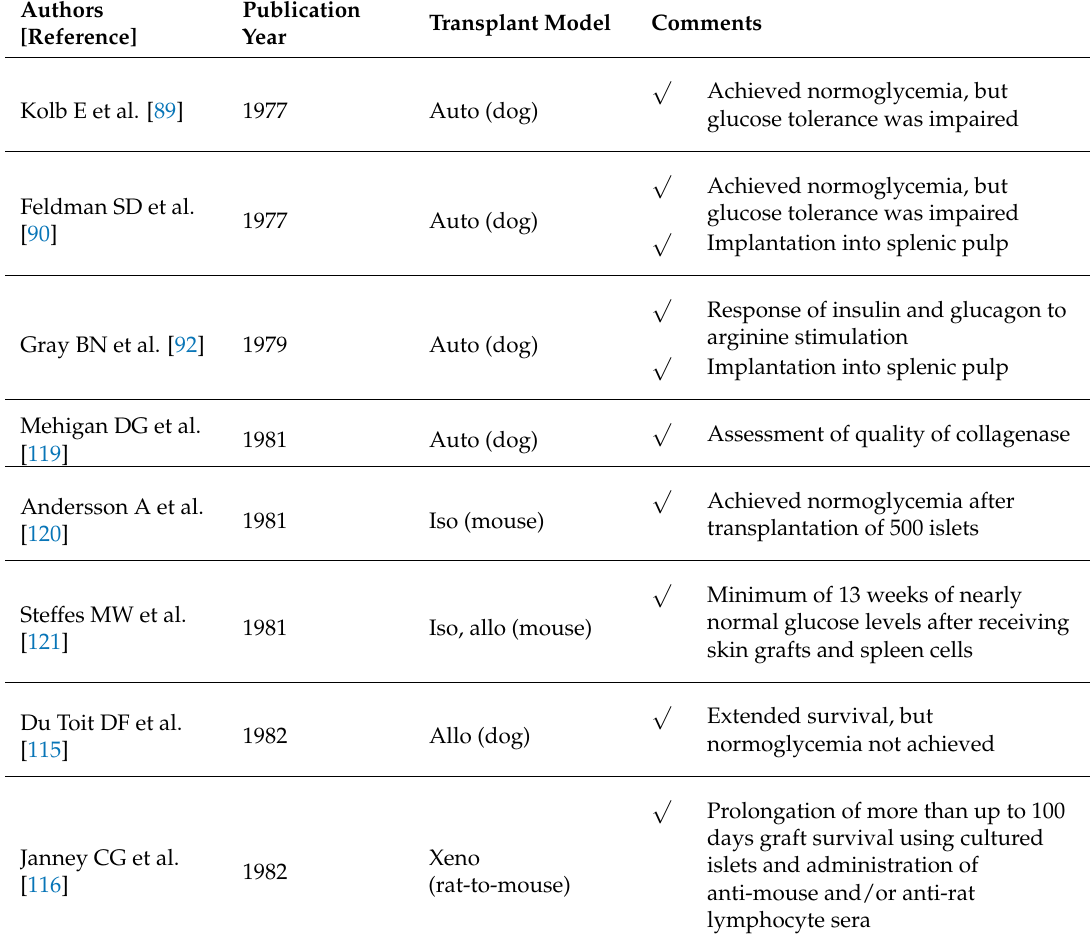
Table 2. Outcomes of intrasplenic islet